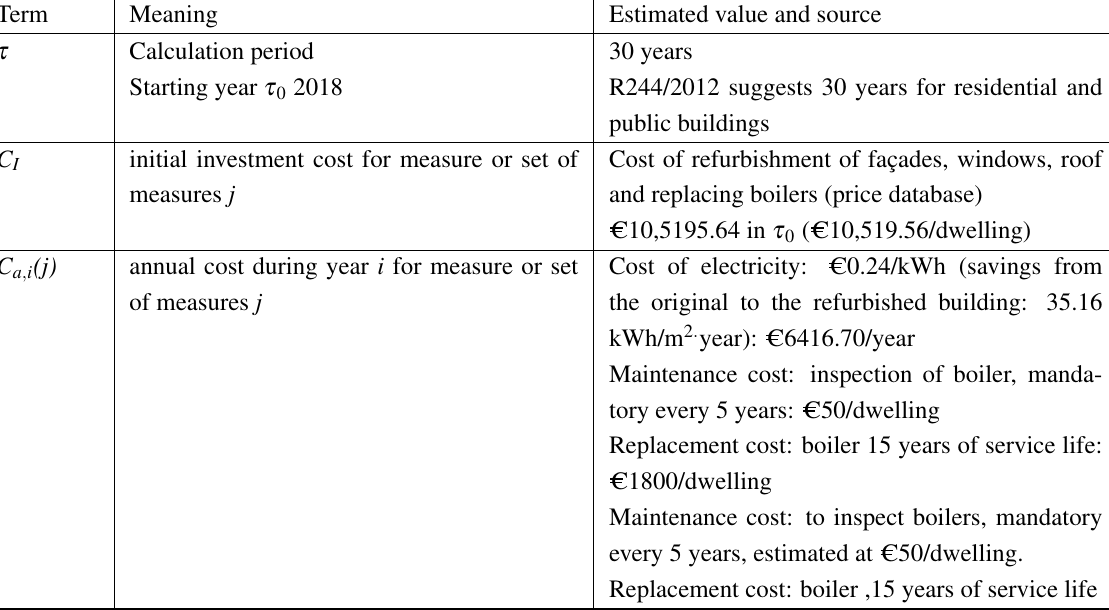
Table 5. Terms for the global cost and hypothesis used for